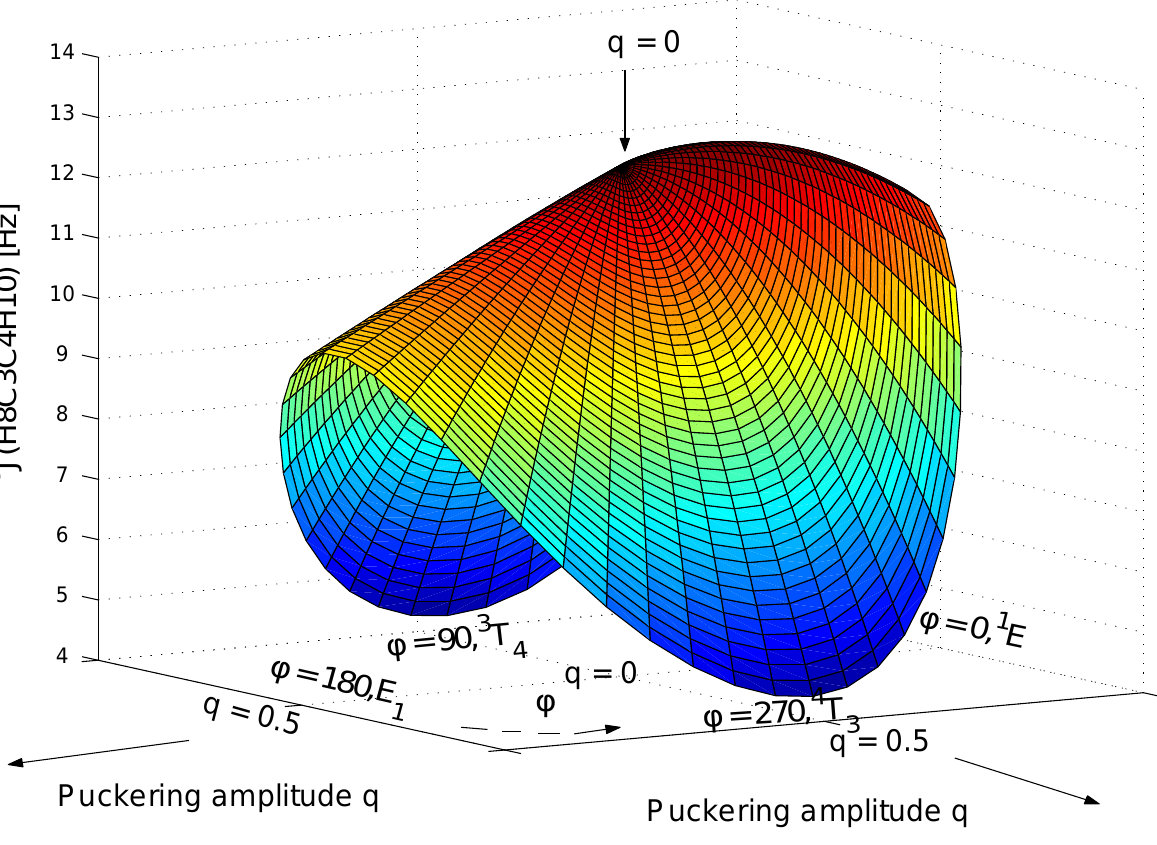
Figure 8: Perspective drawing of the three-dimensional surface J(q, φ ) of SSCC 3 J(H8C3C4H10,cis) of tetrahydrofuran. The SSCC of the planar form with q = 0 is located at the maximum. The direction of radial coordinate q and the angular coordinate φ is indicated. Compare with Figure 1. The drawing is cutoff for q > 0.5